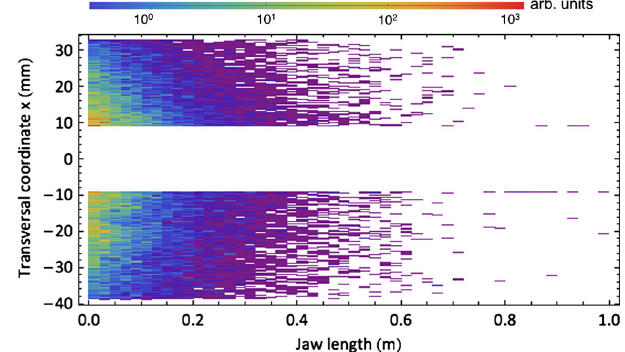
FIG. 7. Density of inelastic nuclear events in the TCTH.4R5.B2 jaws for Case 1. A bin size of 2 cm in s and 20 μ m in x is used. Losses are integrated along y . The TCT setting ( 10 . 5 σ is Case 1) is shown with its value in millimeters, i.e. 9.03 mm from the beam centerline to the edge of the collimator